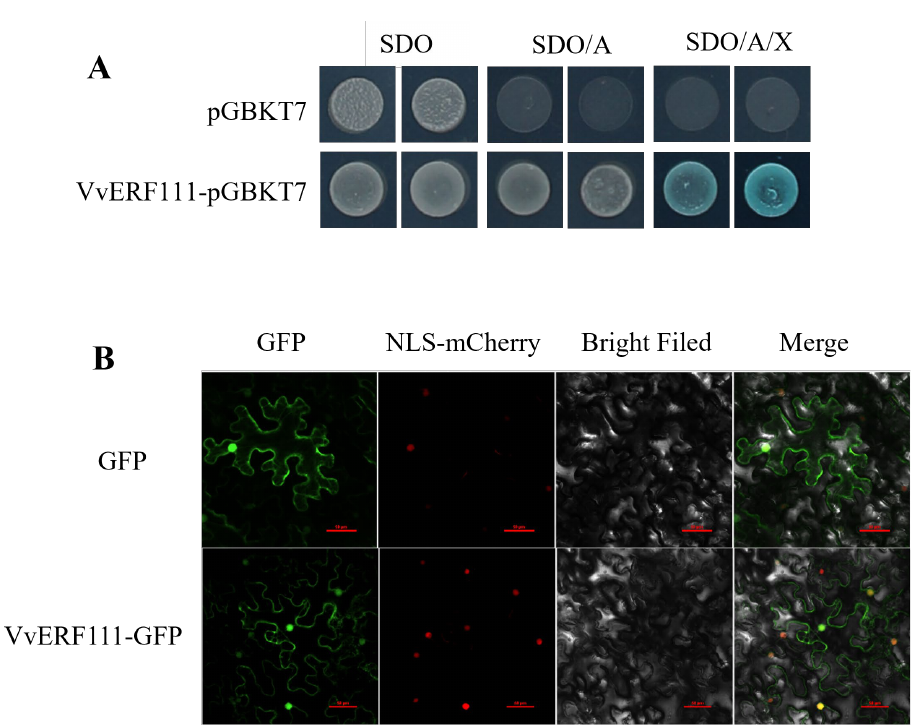
Figure 3. Transcriptional activation in yeast and subcellular localization in tobacco of VvERF111 . ( A ) VvERF111 transactivation activity assay. SDO: synthetic dropout medium; SDO/A: synthetic dropout medium lacking tryptophan and supplemented with Aureobasidin A; and SD/AbA/X: synthetic dropout medium lacking tryptophan and supplemented with Aureobasidin A and X-a-Gal. pGBKT7 vector was used as negative control. ( B ) Subcellular localization of VvERF111 in Nicotiana benthamiana leaves, the colored dots represent nucleus. Bright field, white light; merged, combined GFP, and brightfield signals. pBI221-mCherry fusing the NLS (amino acid sequence PKKKRKV) to a red fluorescent protein was used as nuclear-localized marker. Bar = 50 μm.